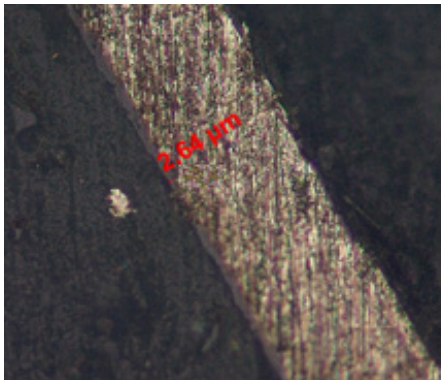
Figure 8. Microscopic section of the strip after seven cycles of 72 h at 440 °C.